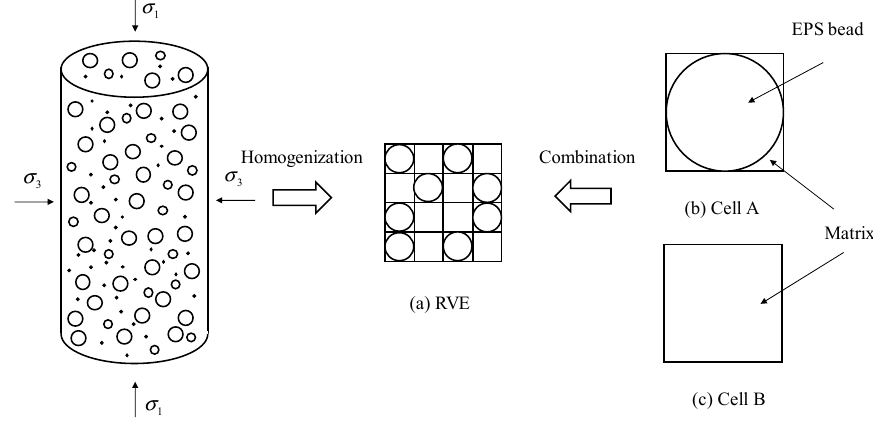
Figure 2. Components of lightweight bulk filling material.